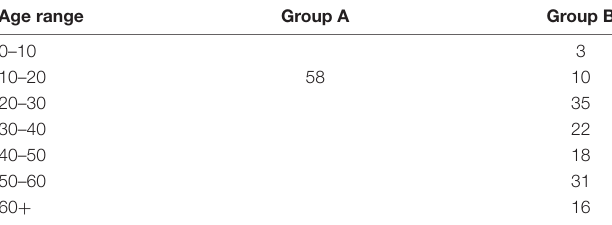
TABLE 3 | Total number of participants in different age ranges for each group.